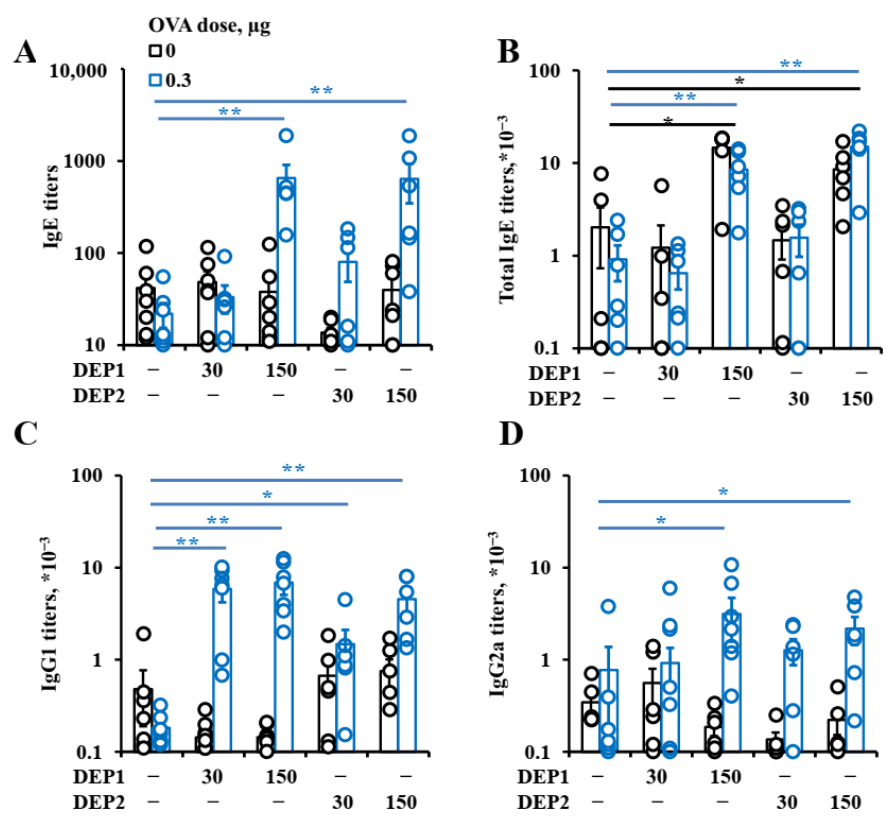
Figure 2. Antibody production in response to low OVA doses, DEPs, or their combination. BALB/c mice were immunized 2–3 times a week for 8 weeks (a total of 18 immunizations) via the i.n. route with 0.3 µ g of OVA alone or with different types of DEP at 30 or 150 µ g. The titers of OVA-specific IgE ( A ), IgG1 ( C ), IgG2a ( D ), and total IgE ( B ) were measured. The statistically significant differences of the groups immunized with OVA with particles vs. the OVA control are shown with blue bars, and the statistically significant differences of the groups immunized with particles alone vs. the saline control are shown by black bars. (*— p < 0.05; **— p < 0.01). The experiment was performed three times. The graphs show the data from three representative experiments (total number of mice included in analysis from all experiments n = 6–7 per group). The data indicate biological replicates obtained from individual